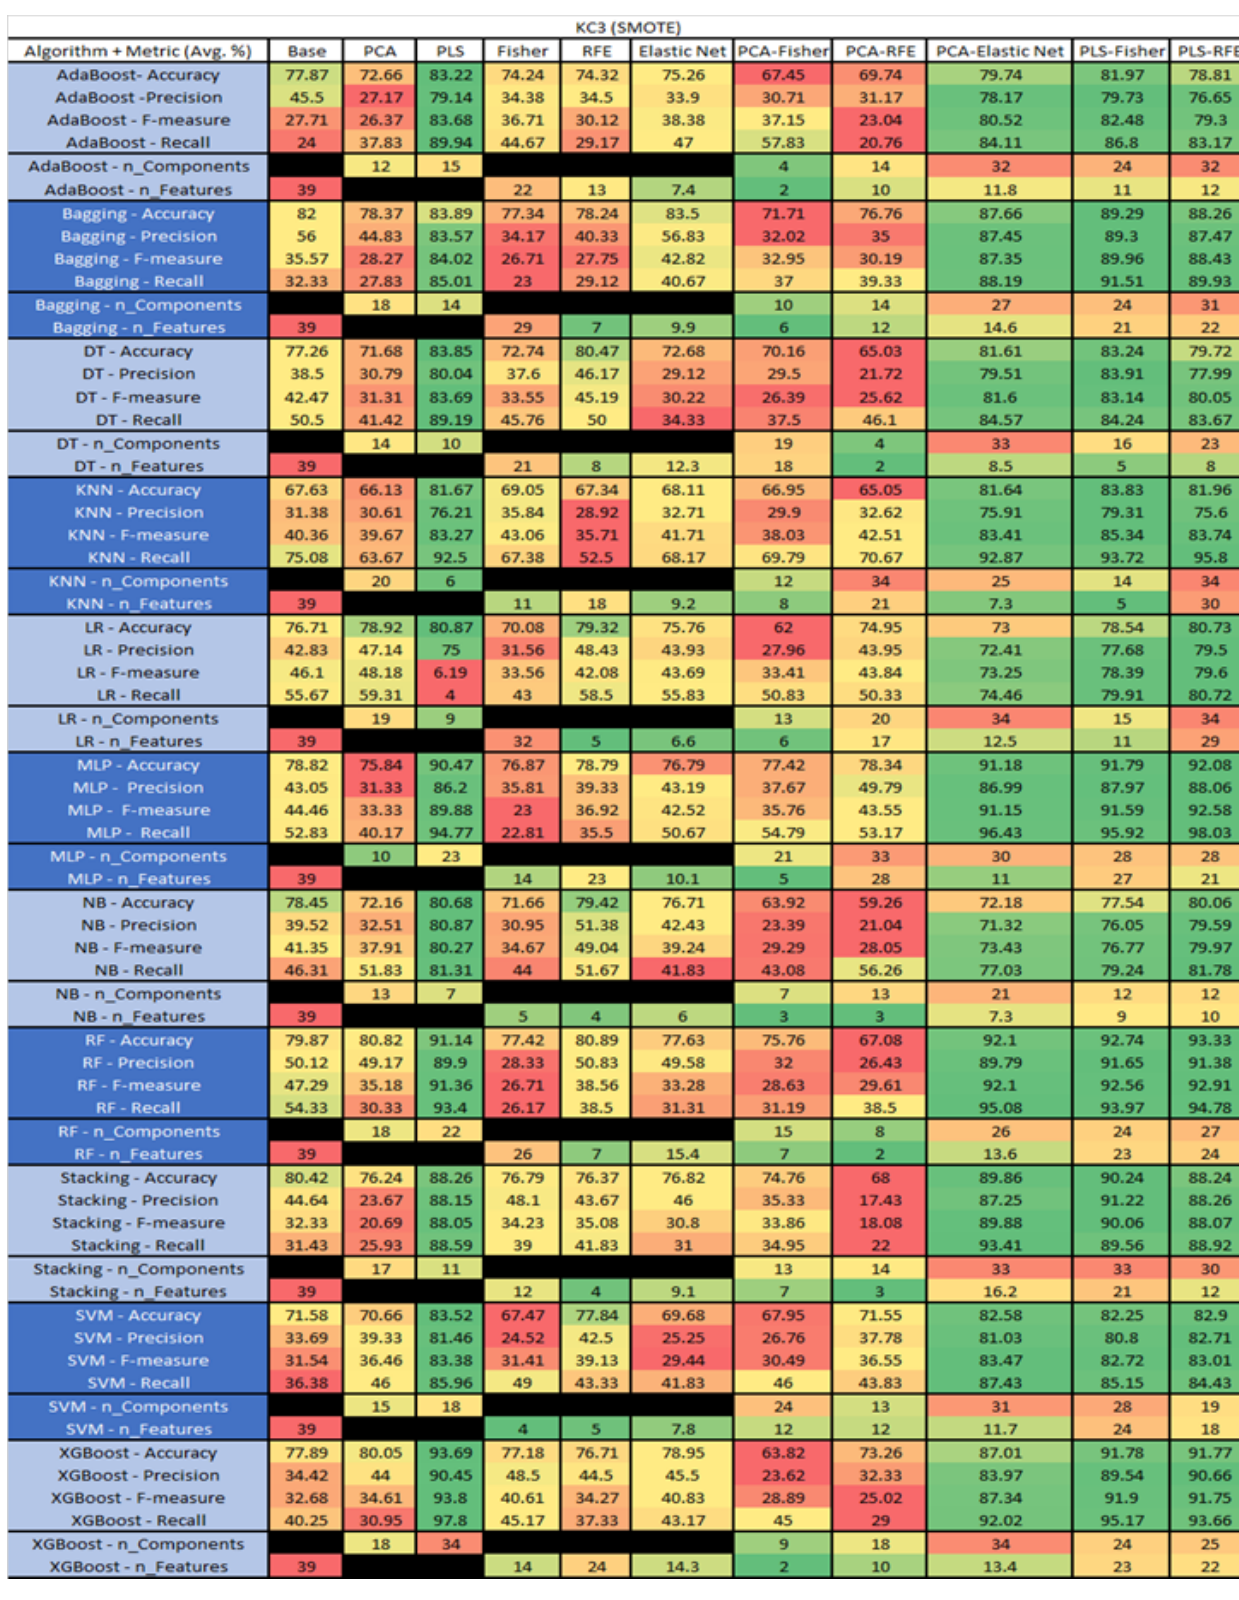
Figure 29. KC3 SMOTE NASA MDP Results Data